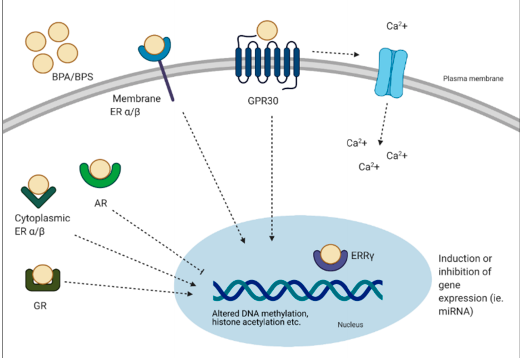
Figure 2. Potential mechanisms of action of BPA and BPS. Bisphenols have been shown to exert both genomic and non-genomic effects. BPA and BPS can bind to the mER- α / β and cytoplasmic ER- α / β , and this receptor-ligand complex can translocate to the nucleus and bind to the promoter of genes to alter expression. Furthermore, BPA can cross the plasma membrane and bind to the glucocorticoid receptor (GR) and androgen receptor (AR) and may act as an agonist or antagonist. In the nucleus, BPA can bind to ERR- γ . Genomic changes may include altered cell proliferation, apoptosis, and differentiation. Binding to mER- α / β can also lead to non-genomic changes, such as altered protein kinase activity, DNA methylation, miRNA, and histone acetylation. Binding of bisphenols to GPR30 can result in rapid non-genomic responses, such as through the influx of Ca 2+ . Dashed arrows indicate possible mechanisms of action. Image created with